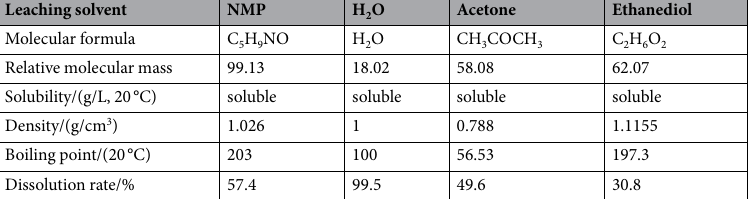
Table 1. Solubility of different solvents.